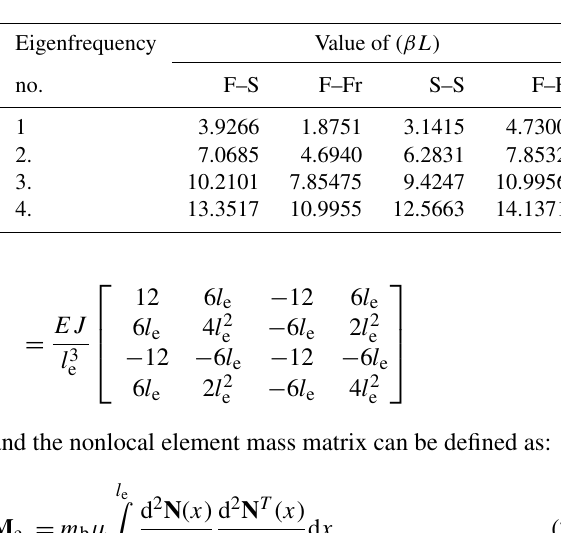
Table 1. Solutions of frequency equations for different boundary